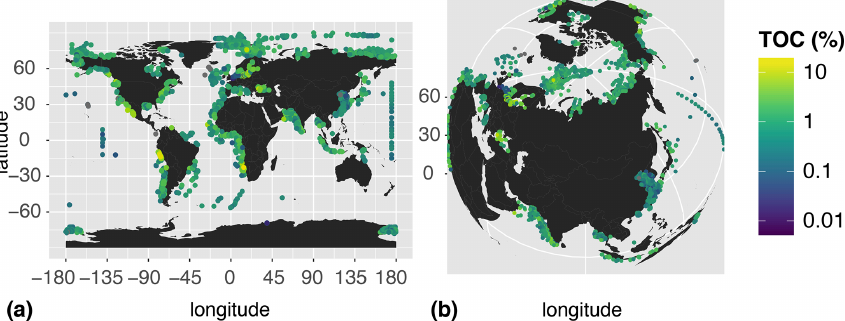
Figure 2. Distribution of all data points across the globe (a) from a standard projection and (b) from a polar-centric projection. Colors indicate TOC content (%).